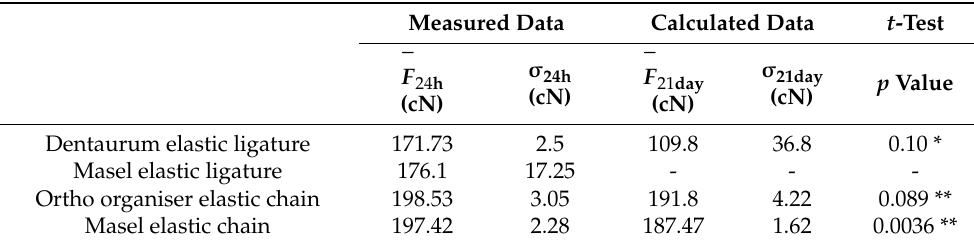
Table 2. Force degradation measurements of the samples measured at 24 h timepoint and the calculated values for day 21. The p value refers to the difference between the meausrements of the 24th hour, and the extrapolated data on the 21st